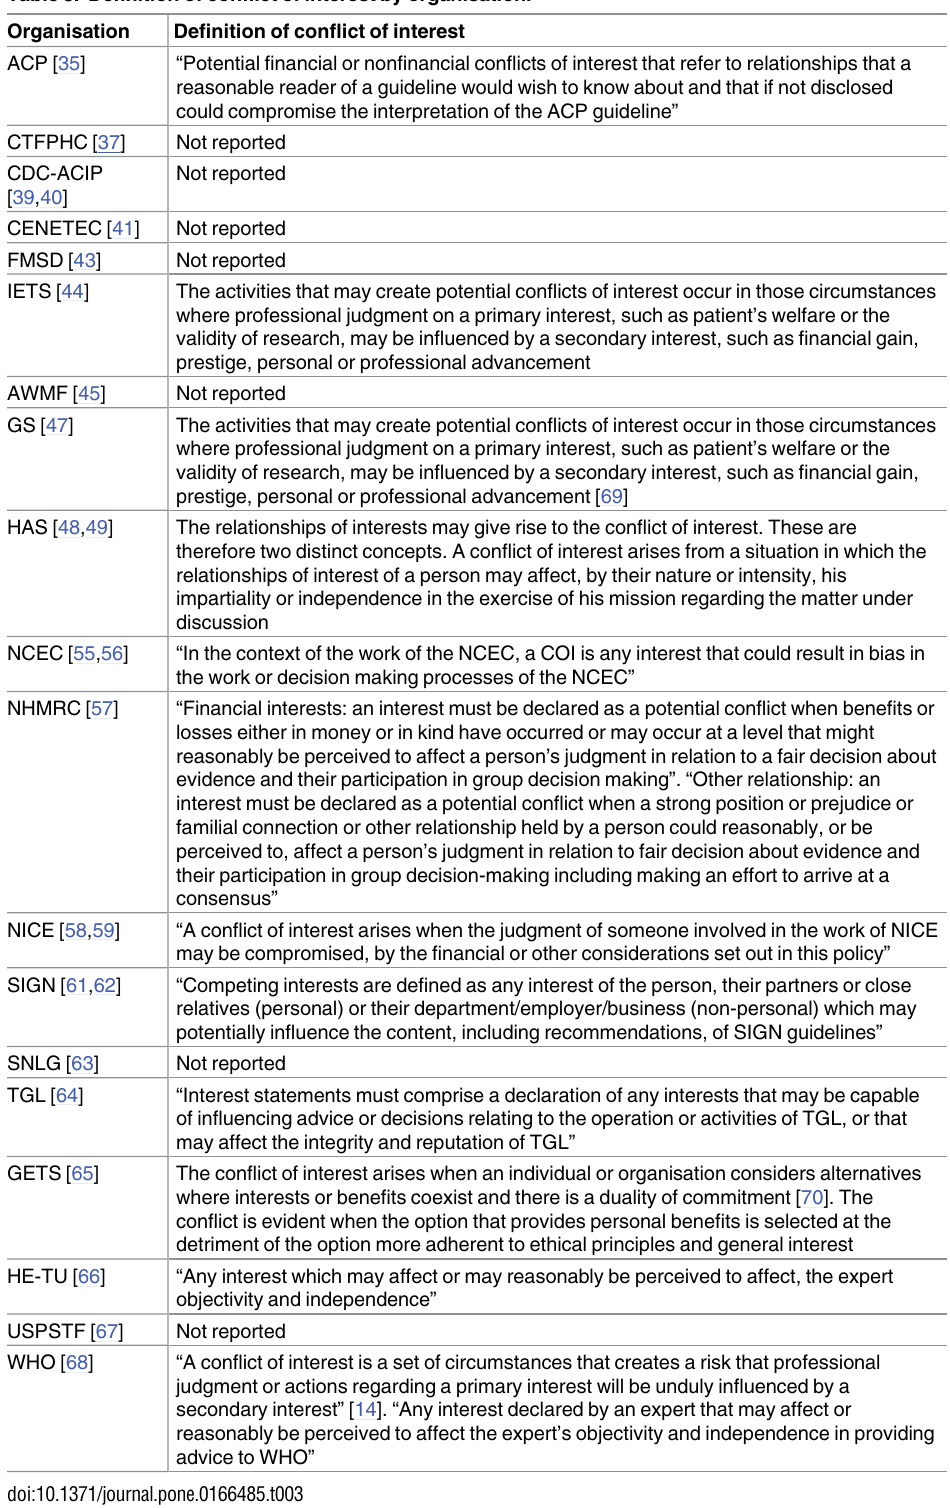
Table 3. Definition of conflict of interest by